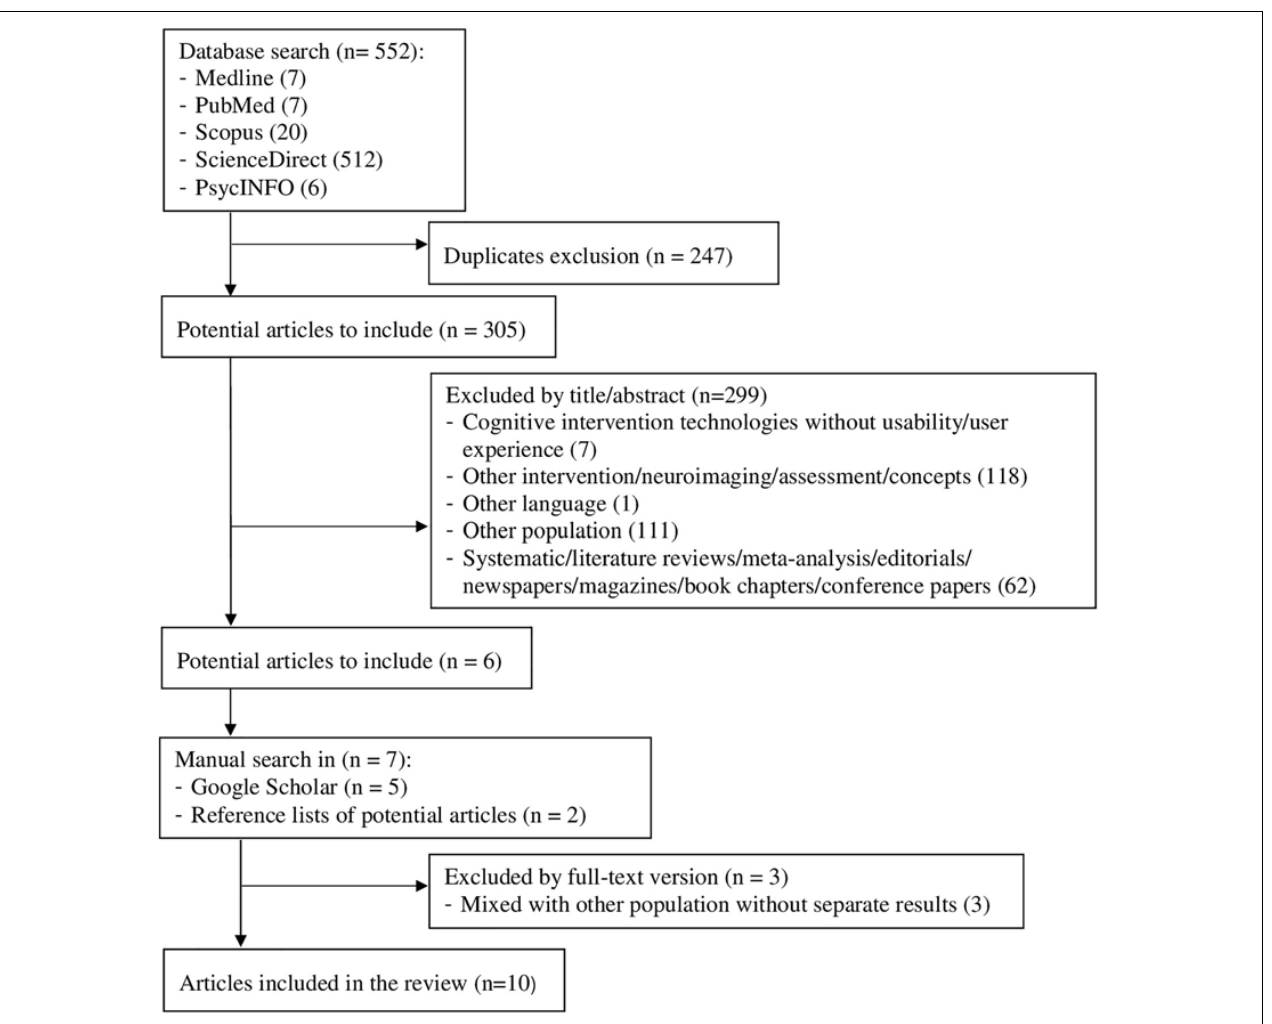
FIGURE 1 | Search procedure and studies